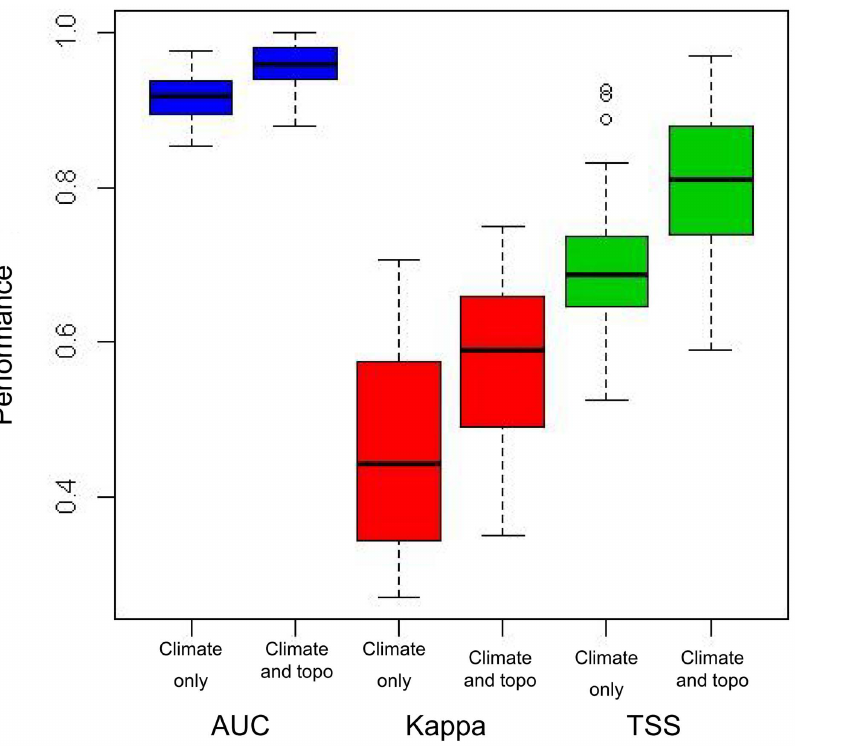
Figure 2. Box plots of the predictive performance of species distribution models for 30 montane species, comparing models with only climate variables to those containing both climate and ecologically relevant topographic variables. The methods of evaluation used were AUC, Kappa and TSS. The difference in performance between models created using climate variables only and climate and topographic variables was significant in all cases (p , 0.001).